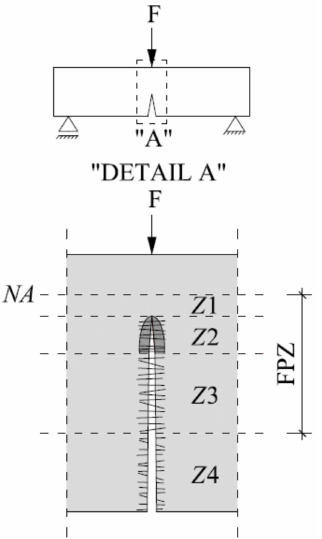
Figure 1. Cross-section of the three-point bending steel fibre reinforced concrete (SFRC) or steel fibre reinforced high-strength concrete (SFRHSC) beam before